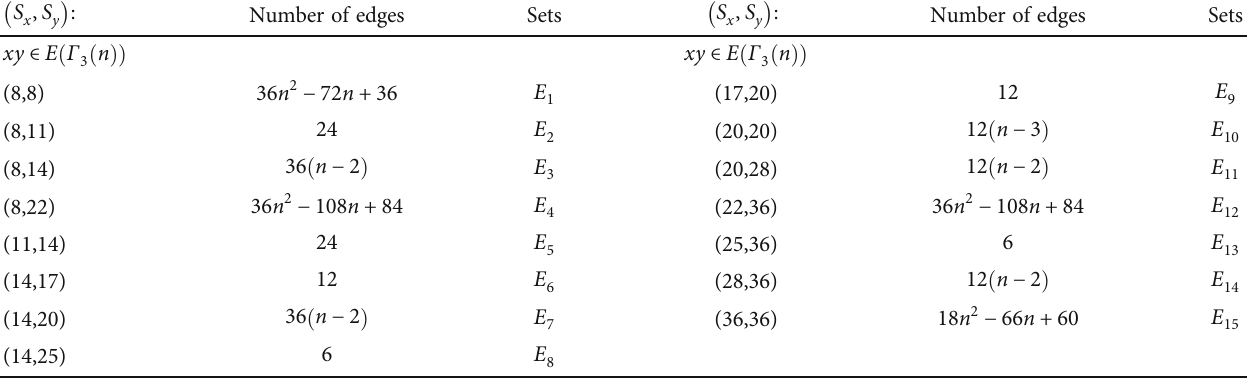
Table 5: Neighbors ’ degree sum based edge partitioning of Γ